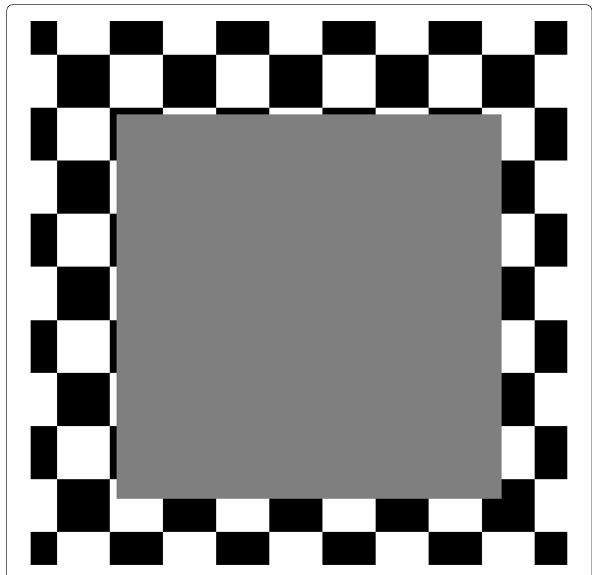
Fig. 5 Trigger alignment with respect to the 8 × 8 JPEG grid. The top-left corner of the squared trigger is misaligned by one pixel to the right and one pixel to the bottom